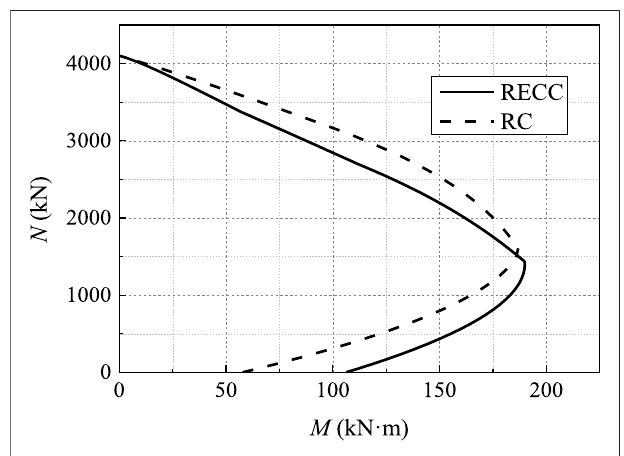
FIGURE 6 | N-M interaction curves of RECC and RC